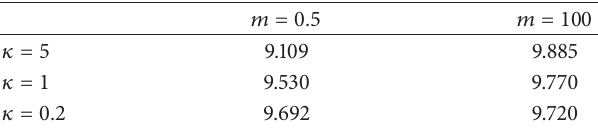
Table 1: Ergodic capacity (in bit/s/Hz) for extreme values of 𝑚 ( 𝜇 = 3 and 𝛾 = 30